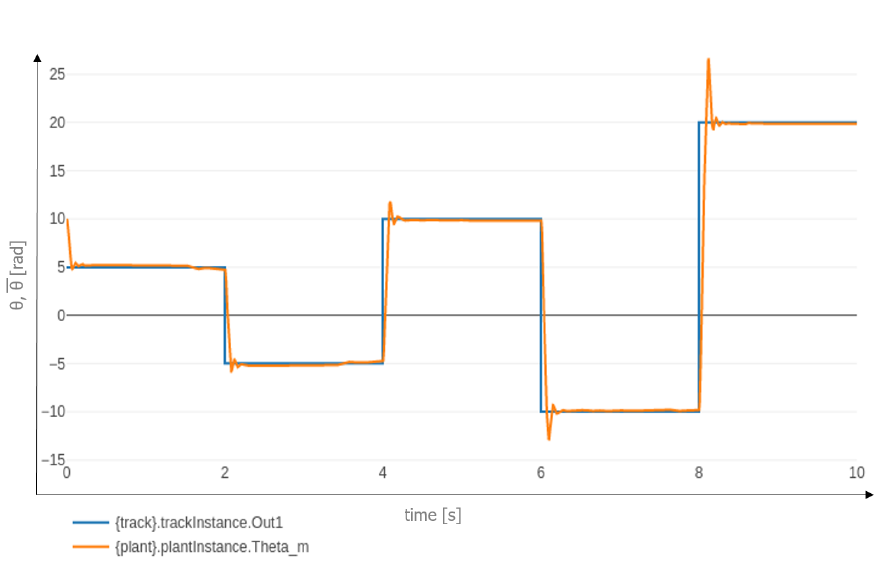
Figure 13. Co-simulation for K 11 = − 1000 and K 22 = −